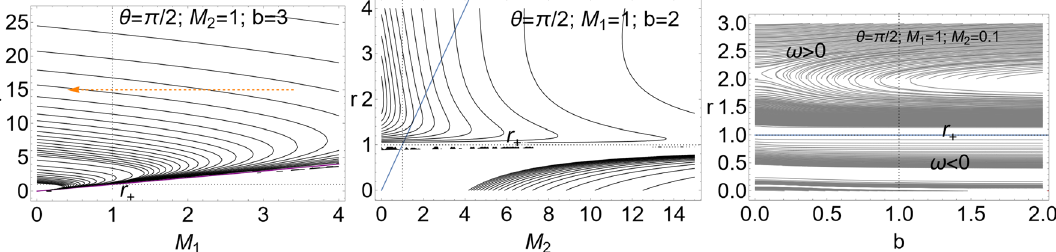
ent values of the charge parameter Q , acceleration parameter α , and cosmological constant Λ . The horizon curves a ± of Eq. (30) are also represented (blue curves)